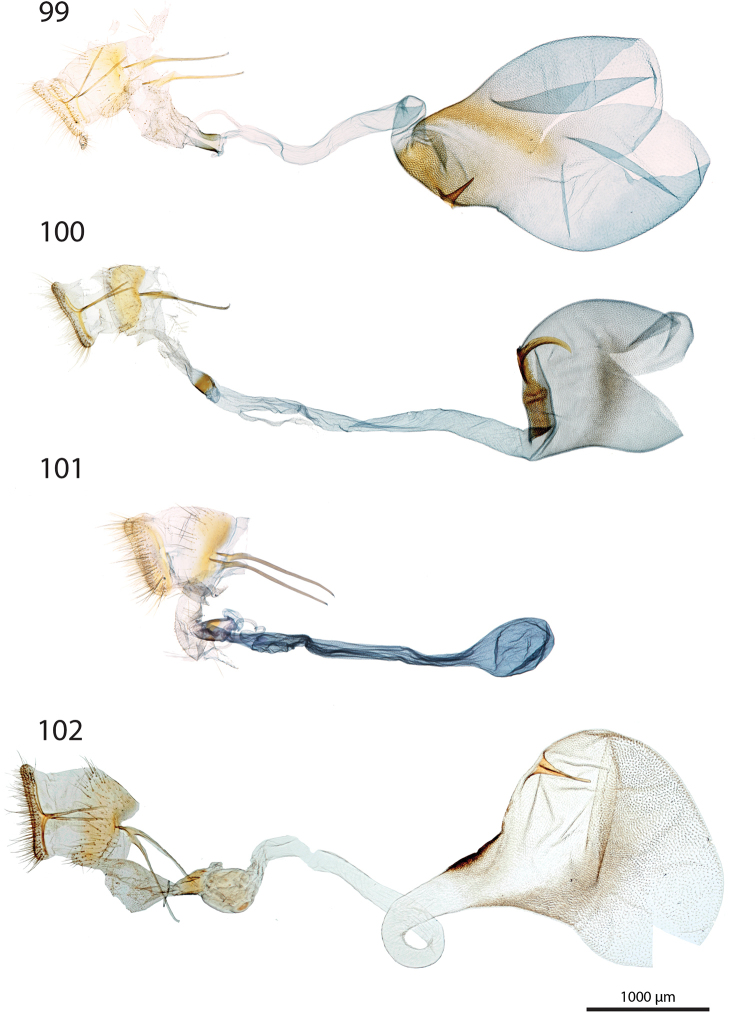
Female genitalia features of Hoploscopa. 99Hoploscopa
danaoensis sp. nov., paratype, TL618 ♀ 100Hoploscopa
isarogensis sp. nov., holotype, TL514 ♀ 101Hoploscopa
tonsepi sp. nov., paratype, TL658 ♀ 102Hoploscopa
aurantiacalis, lectotype, Pyralidae Brit. Mus. Slide N° BMNH20246 ♀.